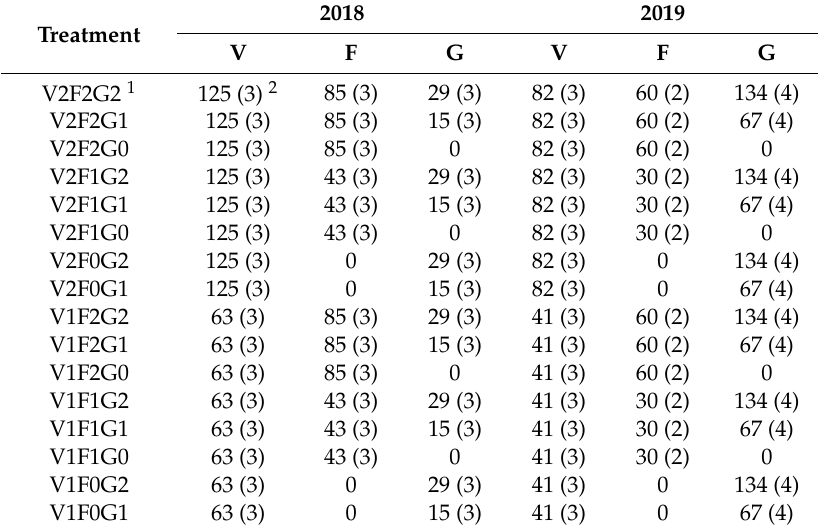
Table 2. Irrigation depth (mm) and times under di ff erent irrigation treatments at the seedling (S), vegetative (V), flowering (F), grain-filling (G), and maturity (M) stages of hybrid maize seed production in 2018 and